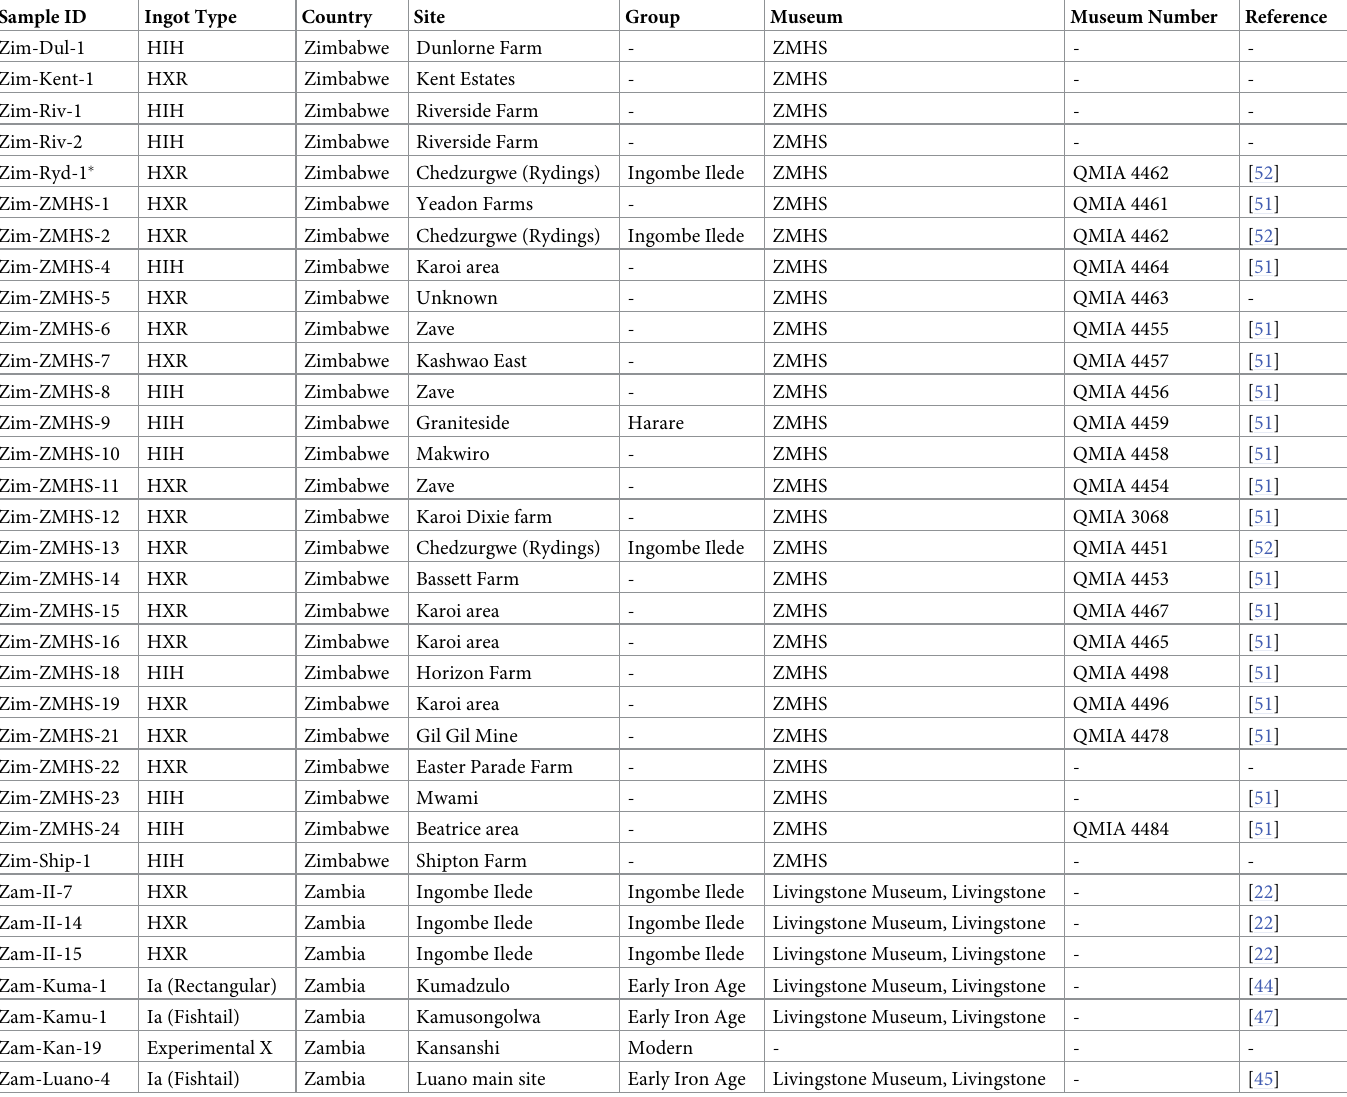
Table 1. Associated information for each sample. Further details for each sample are presented in the S2